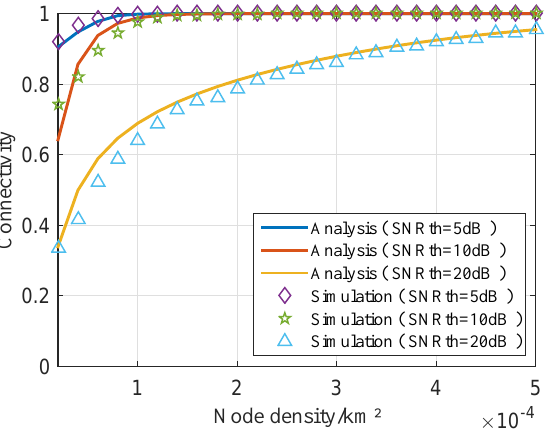
Figure 8. The directly connected probability of the j th cluster with different SNR thresholds.